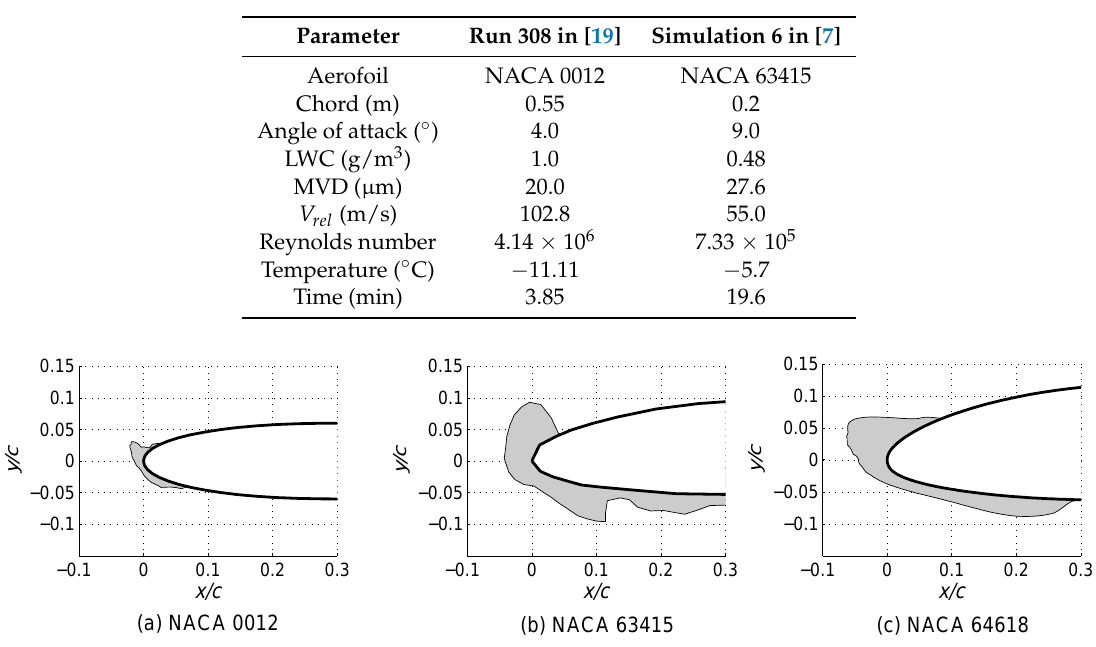
Table 1. Comparison of icing simulation parameters used in [7,19].